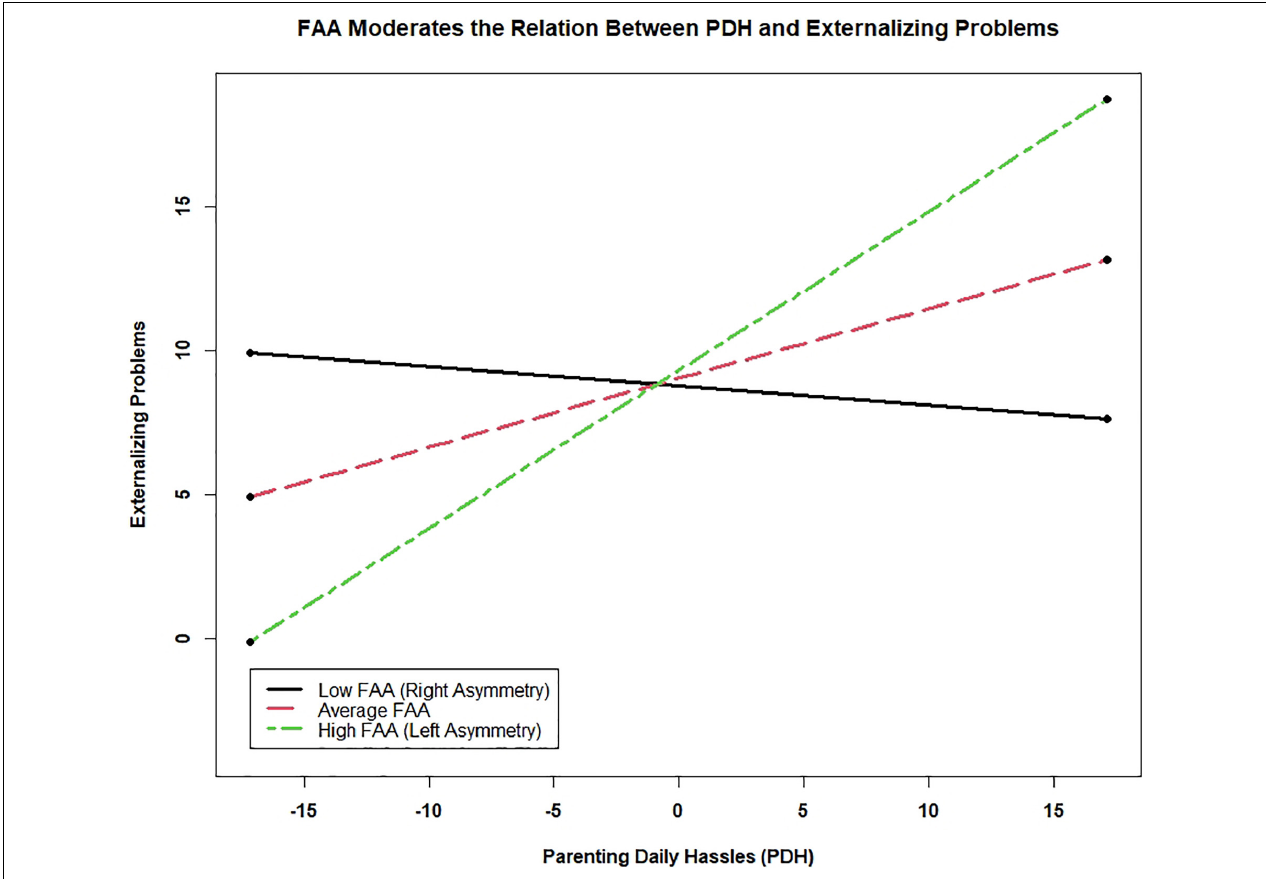
FIGURE 1 | The linear relationship between parenting daily hassles and child externalizing problems is displayed at three levels of the moderator: (1) FAA 1 SD below the mean (i.e., right asymmetry), (2) FAA at the mean, and (3) FAA 1 SD above the mean (i.e., left asymmetry). Parenting daily hassles and FAA were mean centered. The model used for this figure did not contain